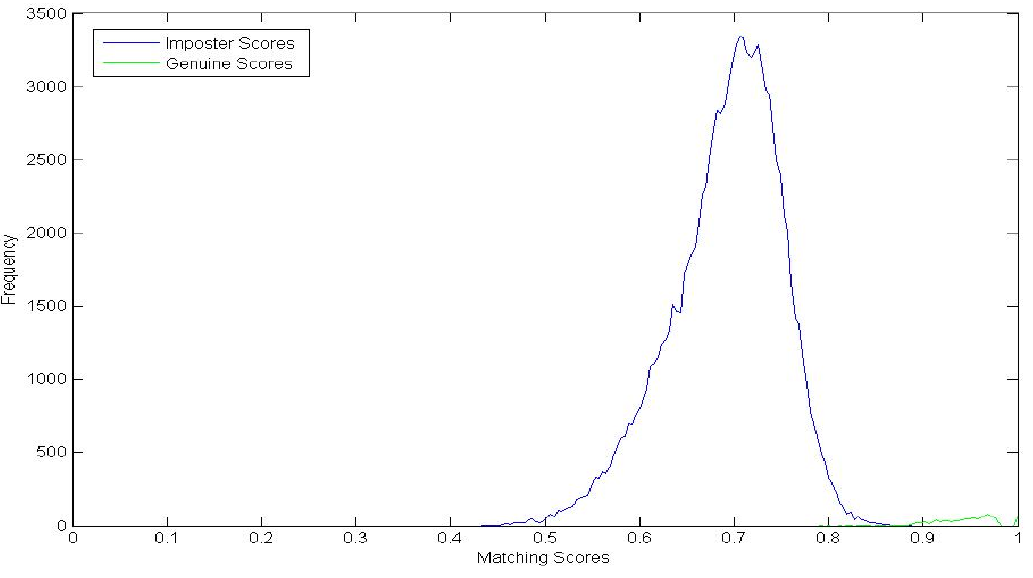
Figure 8. Genuine and imposter matching score distributions by